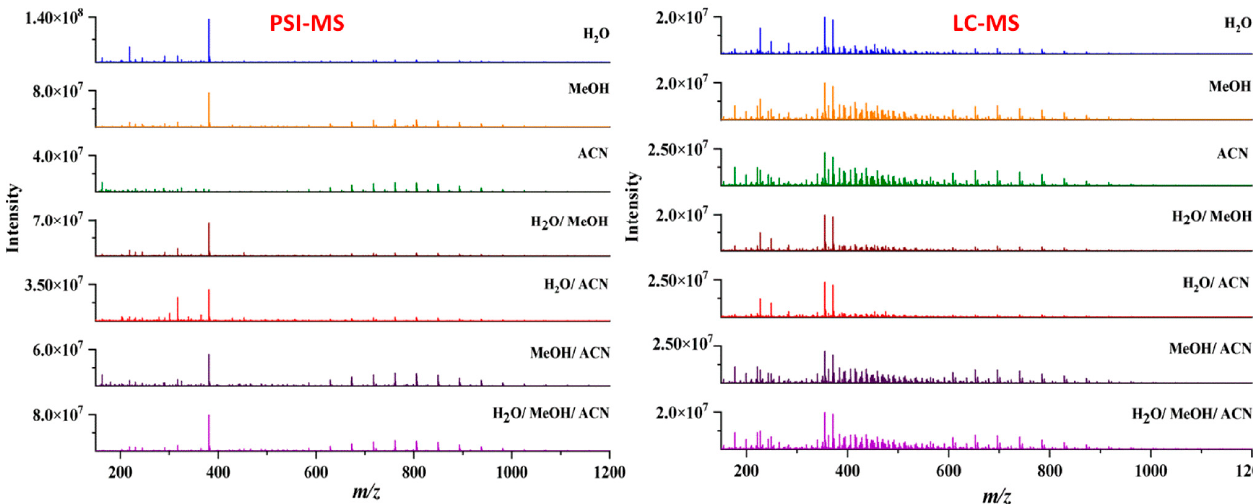
Figure 2. Qualitative comparison of the chemical profiles obtained by paper spray ionization mass spectrometry (PSI-MS) and liquid chromatography–mass spectrometry (LC-MS) from cupuassu ( T.